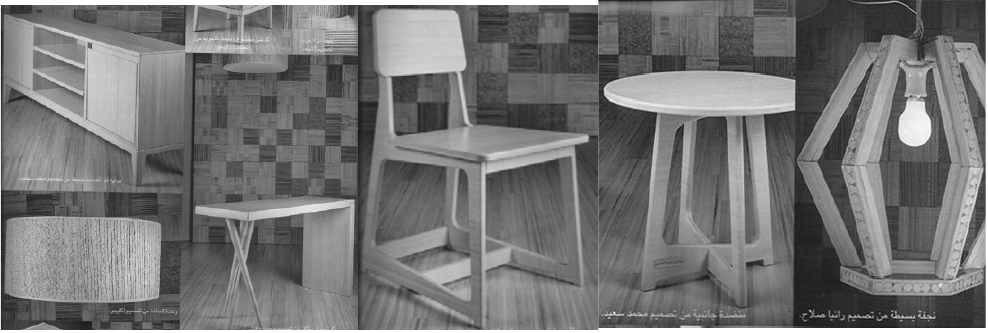
Figure 9. Photographs of tables and chairs, lighting units and desk units